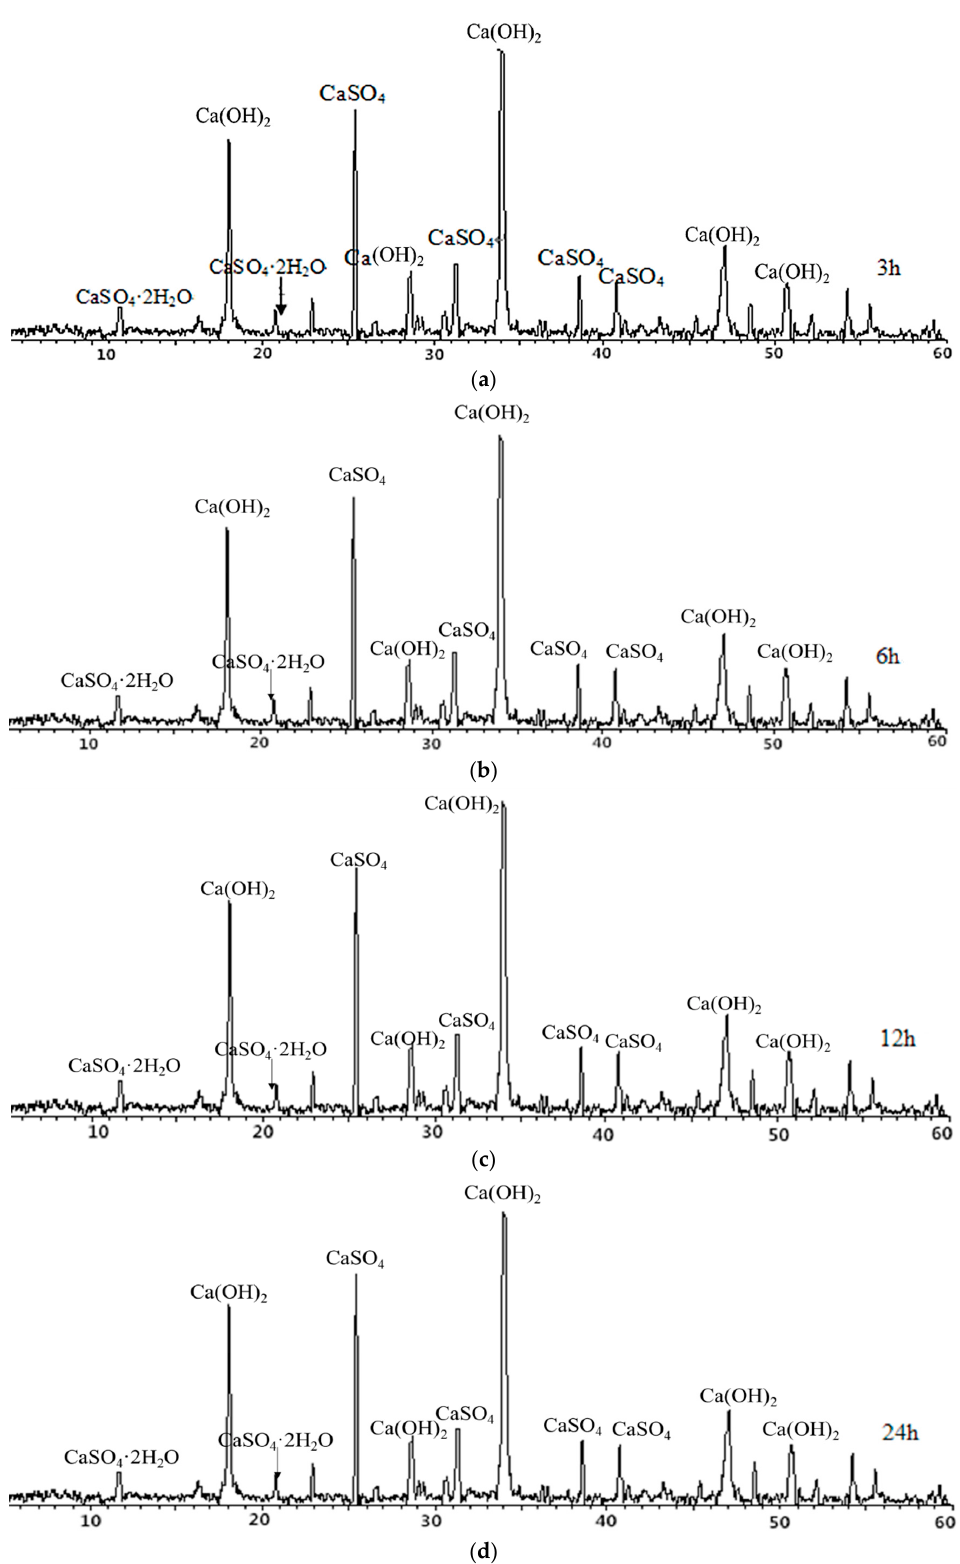
Figure 8. X-ray diffraction (XRD) maps of petroleum coke residue paste at ( a ) 3h, ( b ) 6h, ( c ) 12h, and ( d ) 24h. Figure 8. X-ray di ff raction (XRD) maps of petroleum coke residue paste at ( a ) 3 h, ( b ) 6 h, ( c ) 12 h, and ( d ) 24